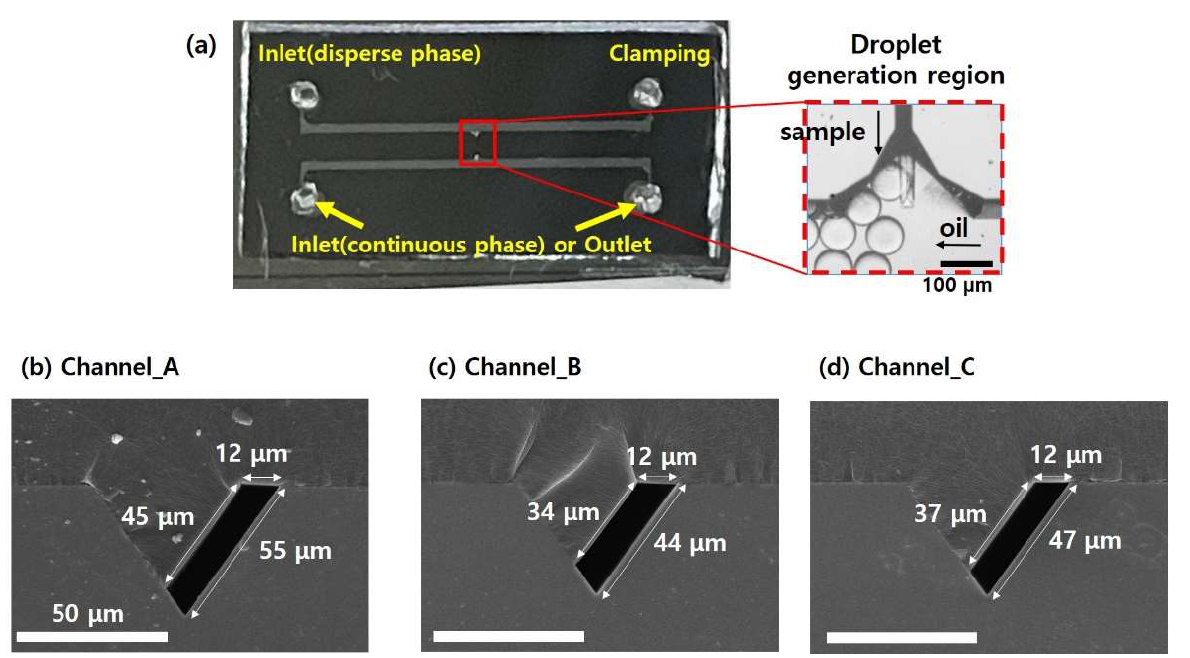
Figure 3. ( a ) Photographs of the developed microfluidic device consisting of the asymmetric cross- sectional channel. The inset illustrates the close-up view of the T-junction micro-droplet generation region. ( b – d ) The SEM images showing the cross-section of the fabricated channels. ( b ) Cross-section of Channel_A with A/W > 3.5 and B/W > 3.5, ( c ) Cross-section of Channel_B with A/W < 3.5 and B/W > 3.5, ( d ) Cross-section of Channel_C with A/W < 3.5 and B/W > 3.5.